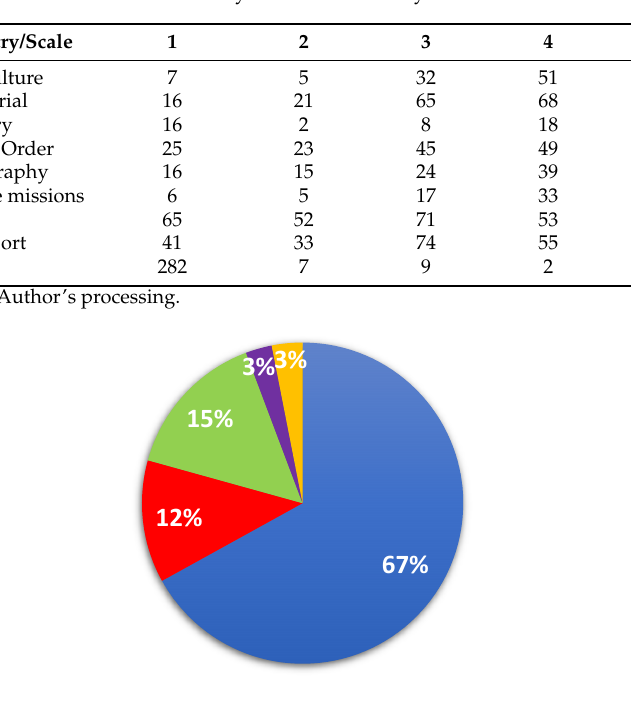
Table 1. Usefulness of drones by sectors of activity.